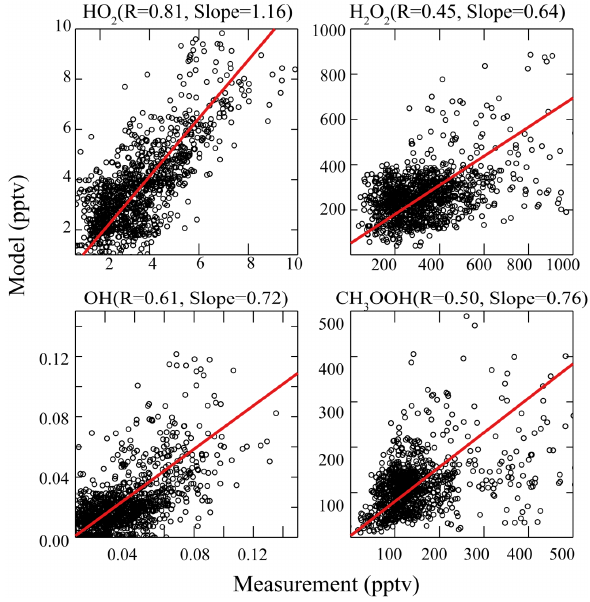
Figure 4 Scatterplots of simulated vs. observed HO 2 , OH, H 2 O 2 , and CH 3 OOH concentrations, for the model simulation with γ (HO 2 → products) and the ensemble of tropospheric observations during ARCTAS (April 2008). The red solid line is the reduced major axis regression line. Panel titles give the correlation coefficients and regression slopes.